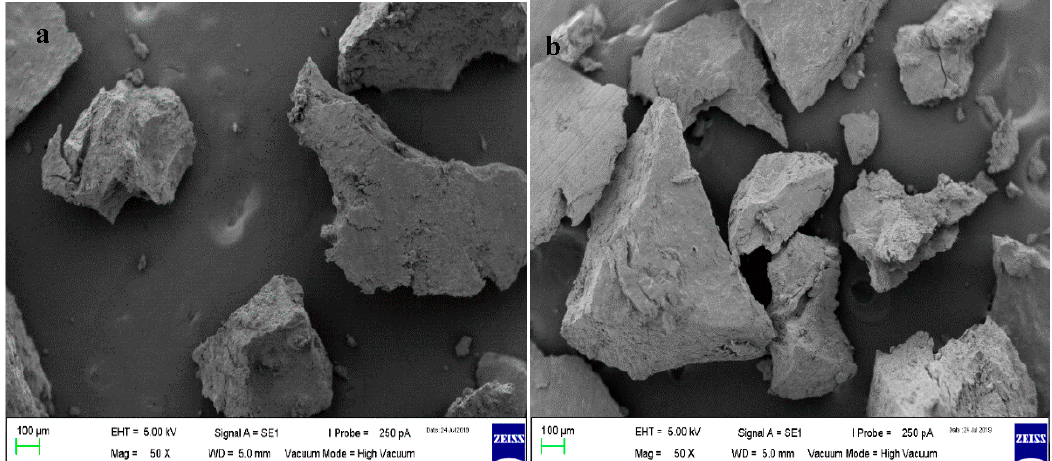
Figure 4. ( a ) ROBS flocs morphology. ( b ) TOBS flocs morphology.